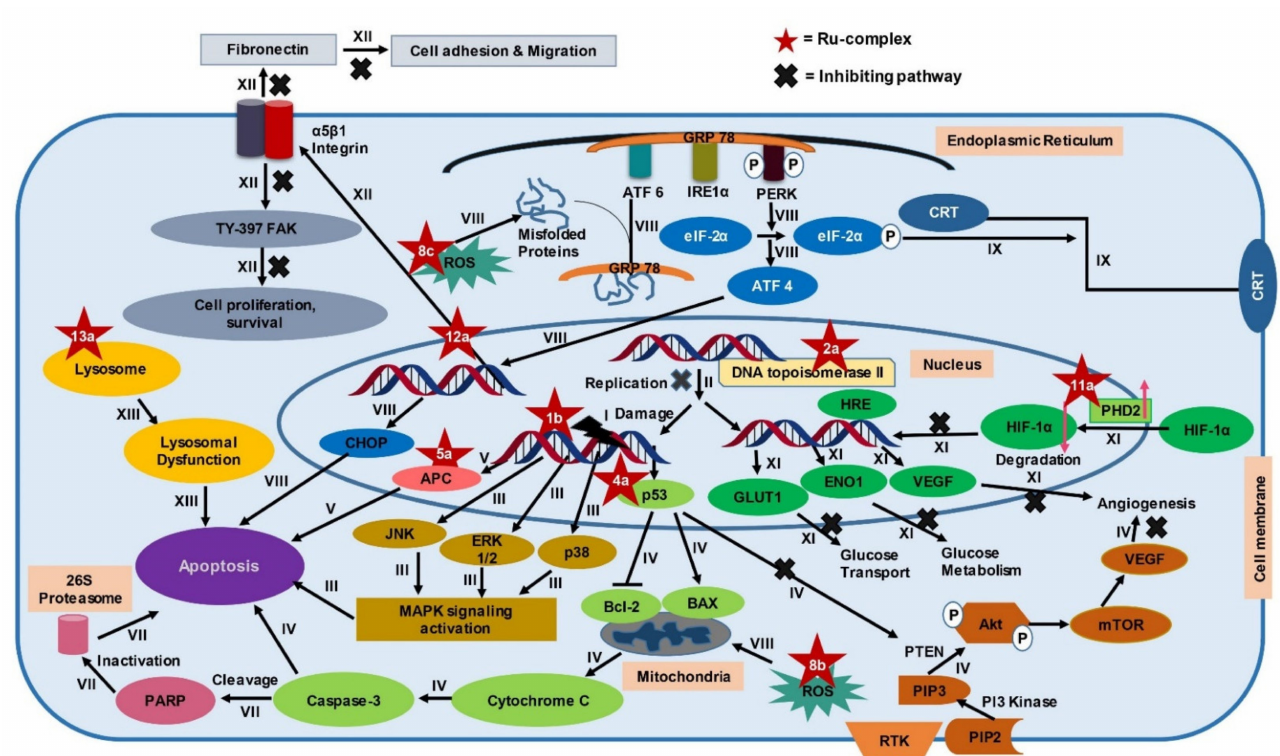
Figure 3. Summary of the suggested molecular mechanisms of some representative Ru-complexes. Different Ru-complexes interact with different cellular signaling pathways of colon cancer cells, thereby suppressing cell growth, proliferation, and migration. Some Ru-complexes can selectively accumulate into subcellular organelle in CRC cells and causes dysfunction leading to cell death. Tyrosine 397 focal adhesion kinase: Tyr-397 FAK; Reactive oxygen species: ROS; Glucose-regulated protein 78: GRP 78; Activating transcription factor 6: ATF6; Inositol-requiring protein 1 α : IRE1 α ; PrKr-like ER kinase: PERK; Eukaryotic initiation factor2 α : eIF2 α ; Calreticulin: CRT; C/eBP homologous protein: CHOP; Adenomatous polyposis coli: APC; Tumor protein P53: p53; B-cell lymphoma: Bcl-2; Bcl-2-associated X: BAX; c-Jun N-terminal kinases: JNK; Extracellular signal-regulated protein kinase 1 and 2: ERK1/2; Mitogen-activated protein kinases: MAPK; Receptor tyrosine kinases: RTK; Phosphatidylinositol 4,5-bisphosphate: PIP2; phosphatidylinositol (3,4,5)-trisphosphate: PIP3; Phosphatase and TENsin homolog deleted on chromosome 10: PTEN; Serine/threonine kinase 1: Akt1; Mammalian target of rapamycin: mTOR; Vascular endothelial growth factor: VEGF; Hypoxia-inducible factor-1 α : HIF-1 α ; Prolyl hydroxylase 2: PHD2; Hypoxia-responsive element: HRE; Glucose transporter 1: GLUT1; Alpha-enolase: